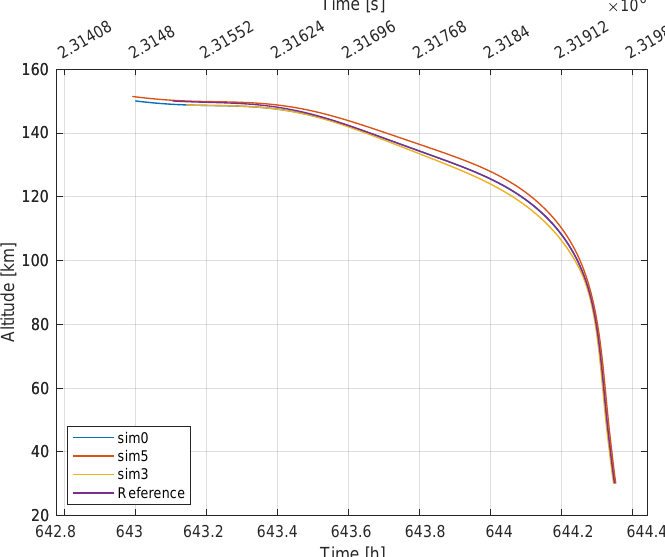
Figure 11. Actual and reference trajectory comparison for the atmospheric approach and the atmo- spheric entry phases. The bottom axis displays the time scale in hours, while the upper axis shows it in